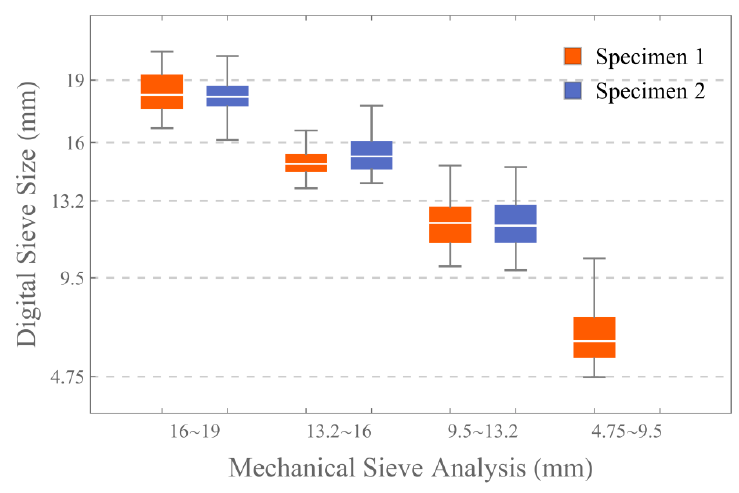
Figure 6. Size of seven specimens based on the digital sieving technique.